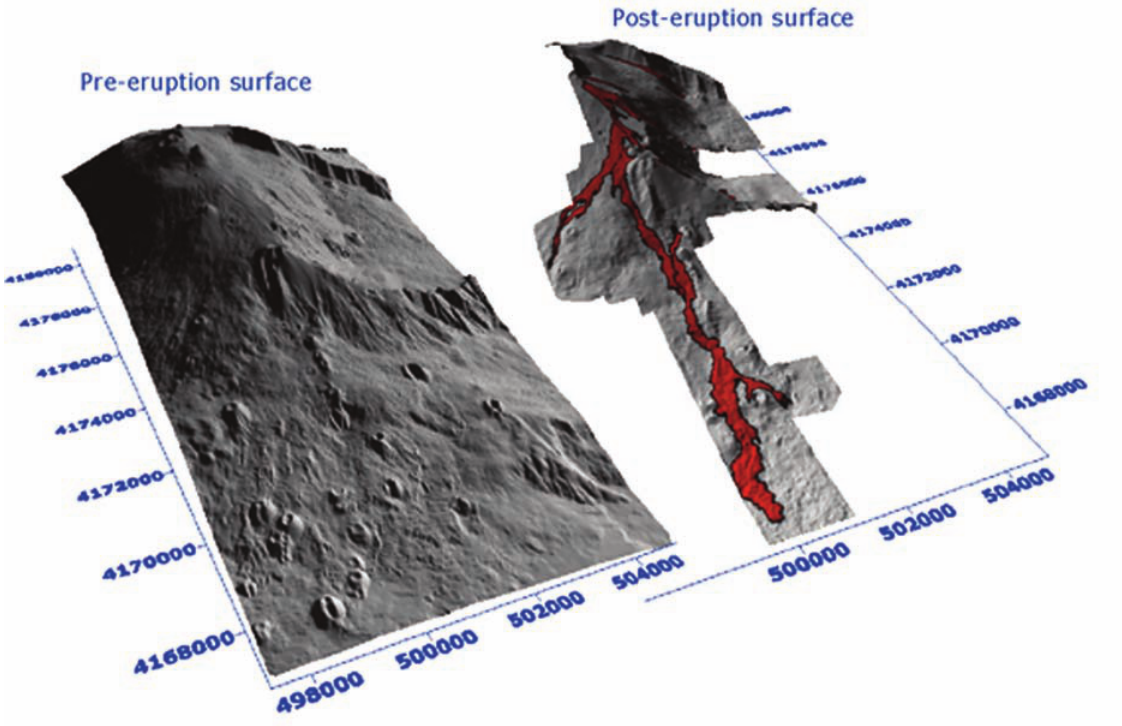
Figure 4. Pre-eruption (left) and post-eruption (right) surfaces of the 2001 Etna eruption, with the lava flow fields superimposed in red on the post- eruption surface.